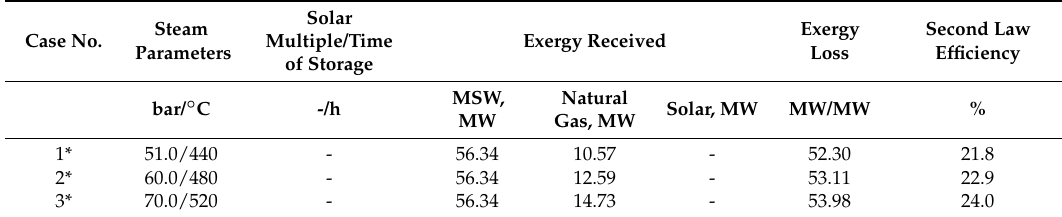
Table 5. Exergy analysis results for the cases with gas